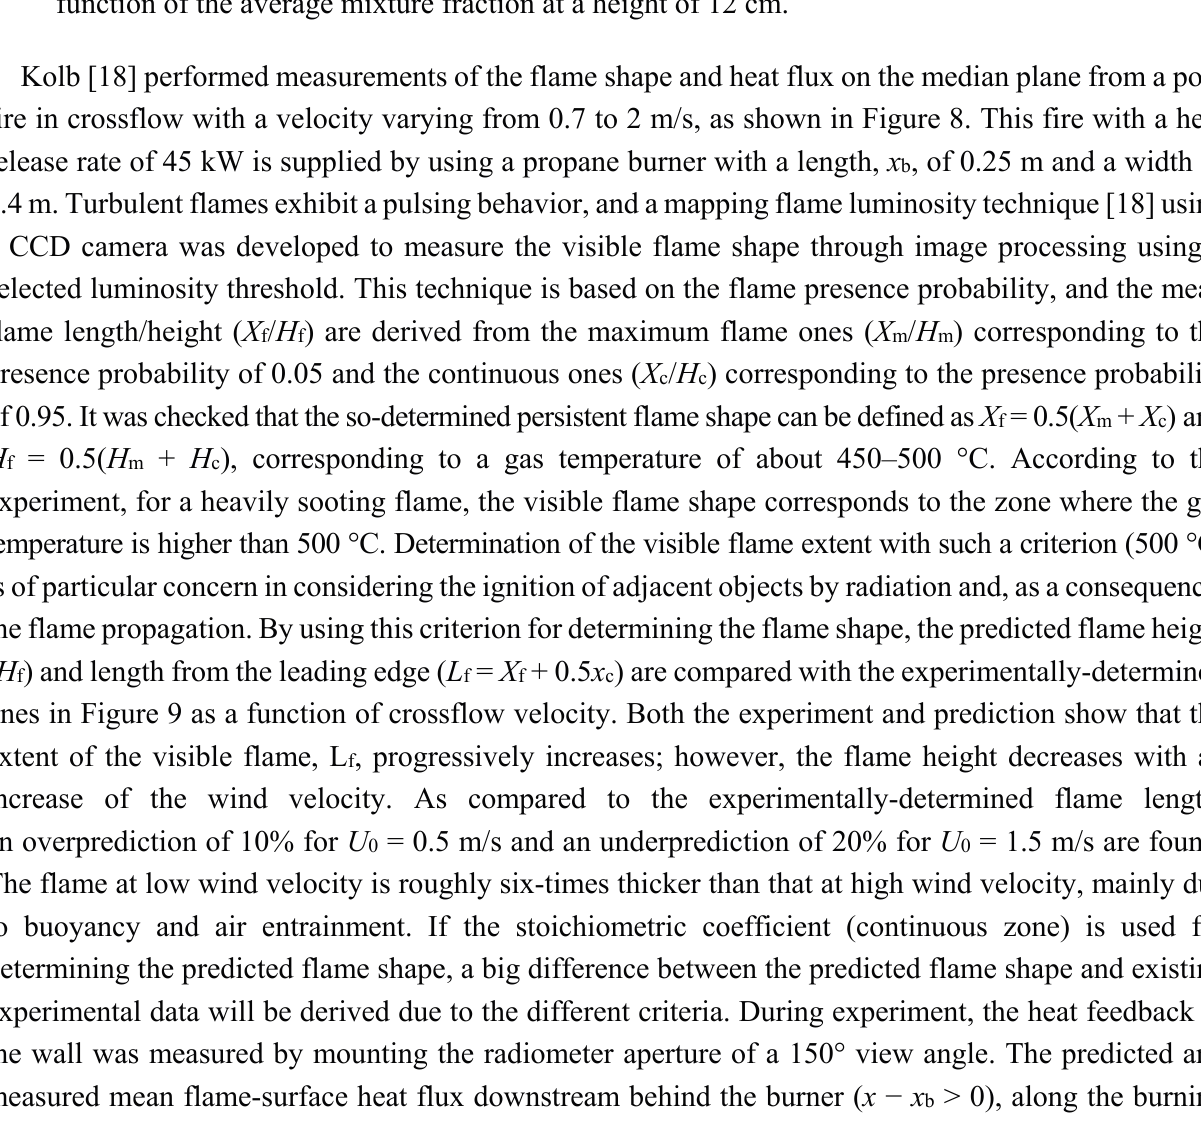
Figure 7. Comparison between the measured and predicted soot volume fraction as a function of the average mixture fraction at a height of 12